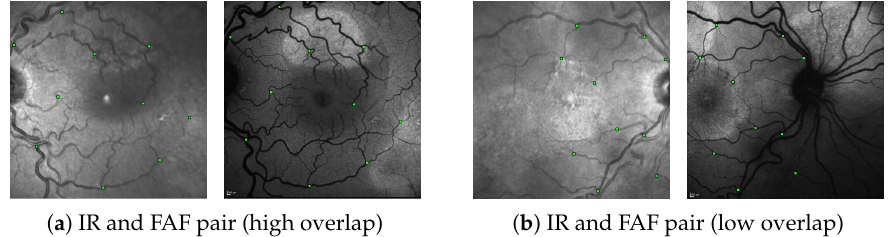
Figure 6. Two annotated IR ↔ FAF image pairs as encountered in our dataset. ( a ) An example with high spatial overlap and ( b ) and example with little spatial overlap. The green squares denote the 10 control-point pairs in each image pair used for evaluation (images are best viewed zoomed in).